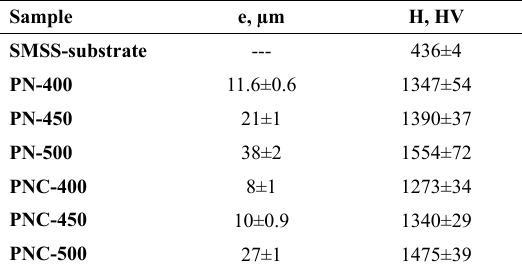
Figure 2. X-ray difraction patterns of plasma (a) nitrided and (b) nitrocaburised SMSS at 400, 450 and 500°C Table 1. Layer thickness (e) and Vickers surface microhardness (H) of the plasma nitrided and nitrocarburised SMSS samples. Sample e, µm